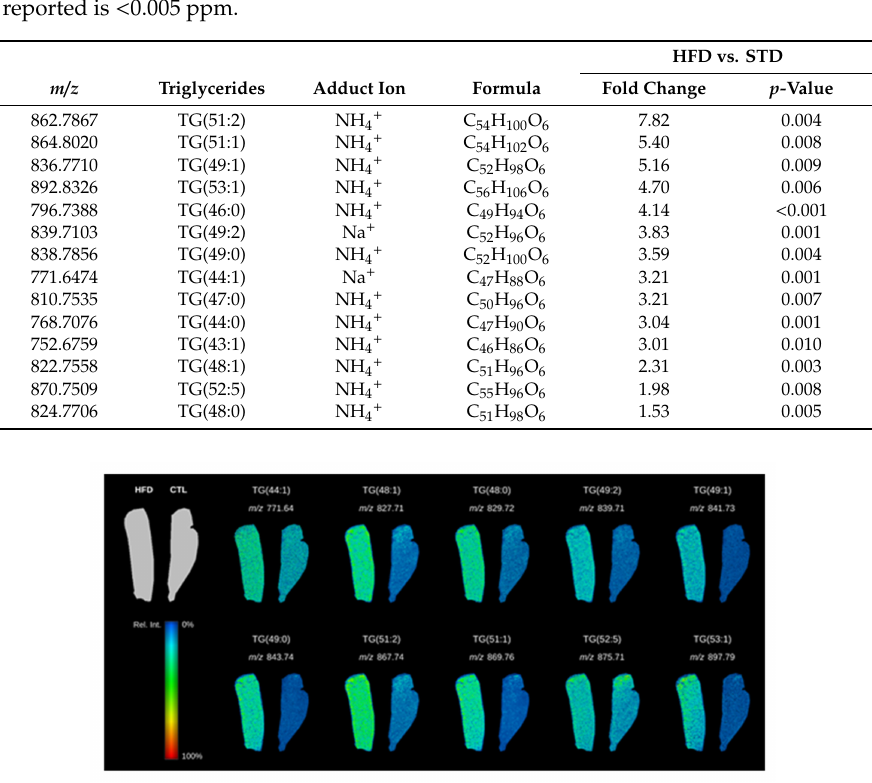
Figure 1. LDI–MS tissue imaging visualization of the distribution of triglycerides in liver cross sections from standard-diet (STD)- and high-fat-diet (HFD)-fed animals. A representative tissue image showing the abundance of 10 of the 14 triglycerides identified by LC-MS is shown. Green color denotes a higher abundance of a particular triglyceride, whereas blue denotes a lower